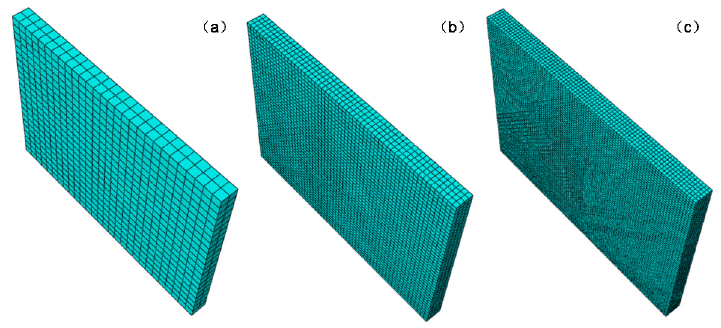
Figure 5. FEA models with different densities: ( a ) h/e = 2; ( b ) h/e = 4 and ( c ) h/e = 6.